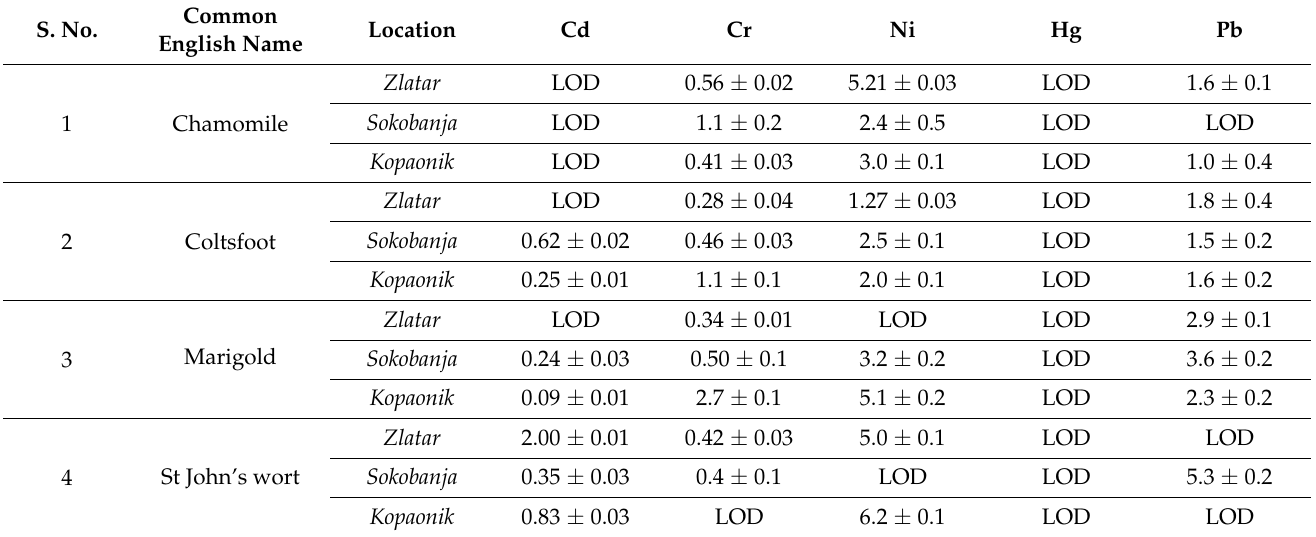
Table 2. The heavy metal content in the investigated medicinal herbs (mg/kg ± expanded uncer- tainty) from Serbia (Zlatar, Sokobanja and